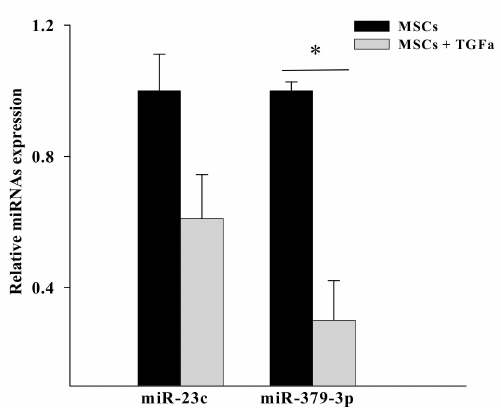
Figure 2. Expression levels of miR-23c and miR-379-3p in conditioned media from untreated and TGF α -treated MSCs. The levels of the expression of miR-23c and miR-379-3p were quantified by Real-time PCR. Conditioned medium from untreated MSCs was used as calibrator. (* p ≤ 0.05 for comparison between untreated versus TGF α -treated MSCs, two-tailed Student’s t -test).